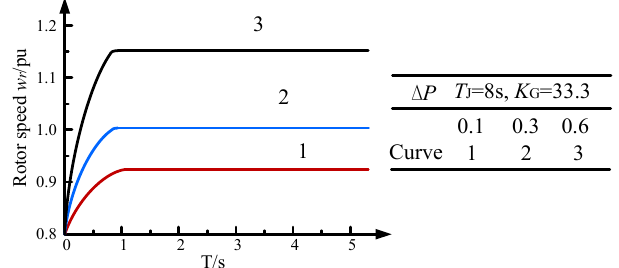
Figure 16. Transient speed-change process of doubly fed induction generator with T J = 8 s, K G = 33.3, Δ P = 0.1,0.3,0.6.